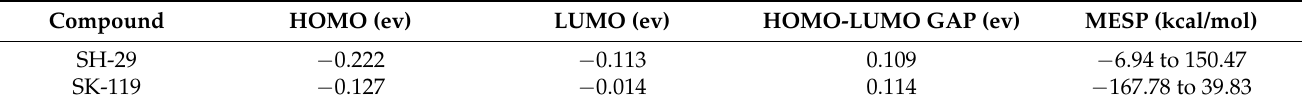
Figure 4. Representation of HOMO, LUMO, and MESP on compound SH-29 and compound SK-119. Table 2. Single point energy value of frontier orbital energies and electrostatic potential.